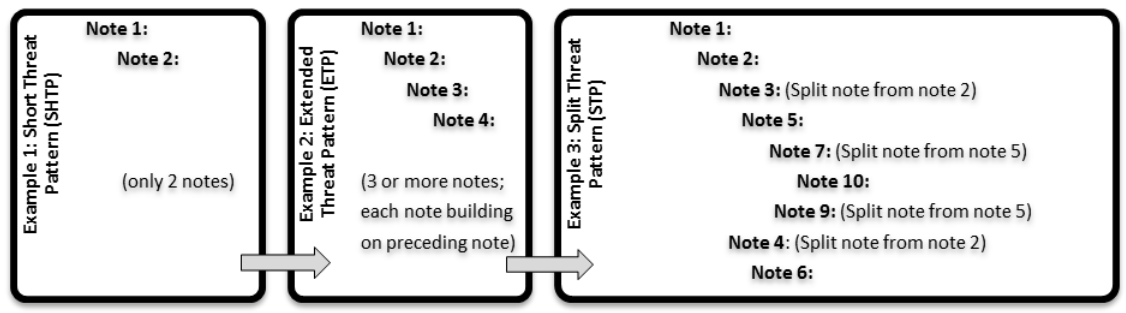
Figure 2. Overview of Chan et al.'s (2009) taxonomy for thread